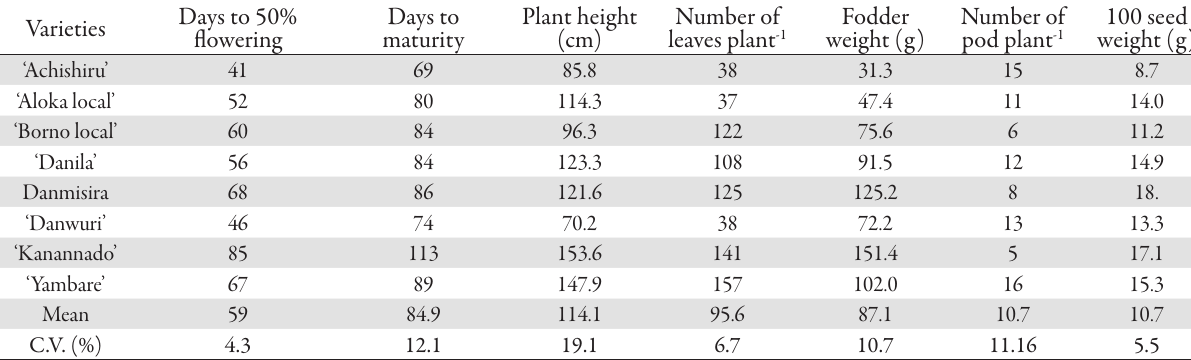
Tab. 1. Mean values for growth and yield parameters in